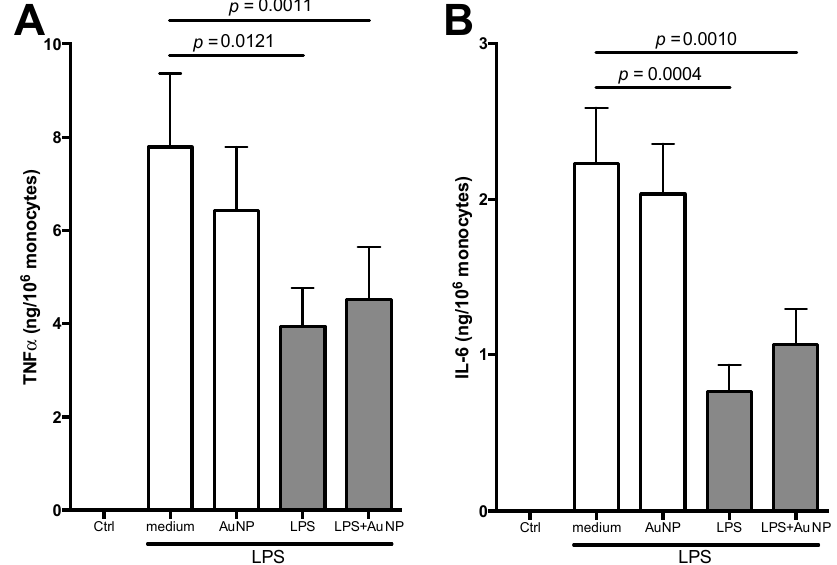
Figure 4. Secondary response of human monocytes primed with LPS and AuNP. Following primary activation (in x-axis: medium, AuNP, LPS, LPS + AuNP), cells were rested for six days and then challenged with LPS (5 ng/mL) for 24 h. Supernatants were tested for TNF α ( A ) and IL-6 ( B ). Ctrl represents the response of cells challenged with medium (the lack of response was identical in cells previously primed with medium, AuNP, LPS, or LPS + AuNP). Results are reported as mean ± SEM of data from 4 individual donors, tested in four separate experiments. Further, p values are indicated when p < 0.05. Although statistically significant, we have not reported in the figure the differences between AuNP and LPS ( p = 0.0203 for TNF α , and p = 0.0009 for IL-6) or between AuNP and LPS + AuNP ( p = 0.0491 for TNF α , and p = 0.0011 for IL-6).